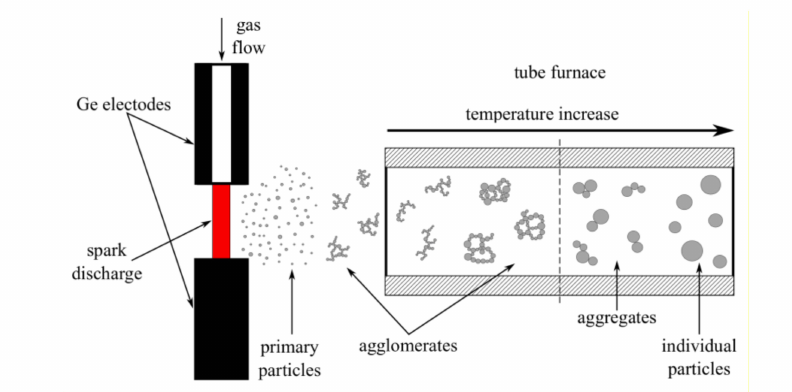
Figure 1. The schematic of the formation of nanoparticles in the spark-discharge aerosol generator, supplemented with the tube furnace heated to di ff erent temperatures. The temperature of the tube is constant along the whole length of the furnace. One can a ff ect the morphology and size of nanoparticles by controlling the